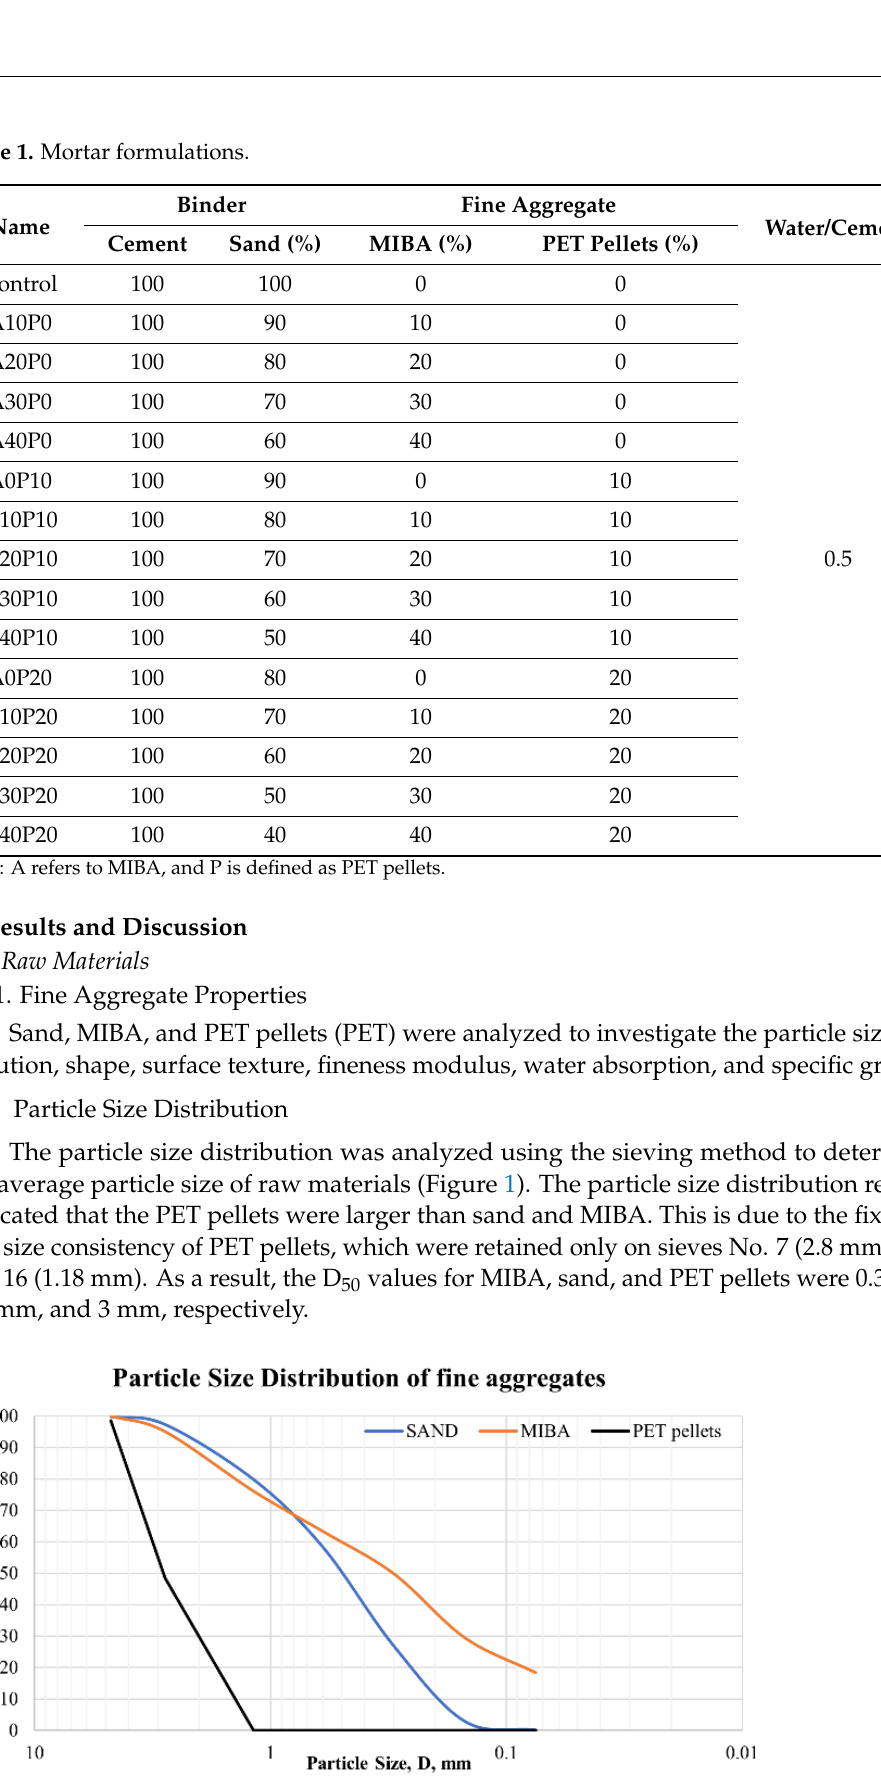
Figure 1. Particle size distribution of fine aggregates.